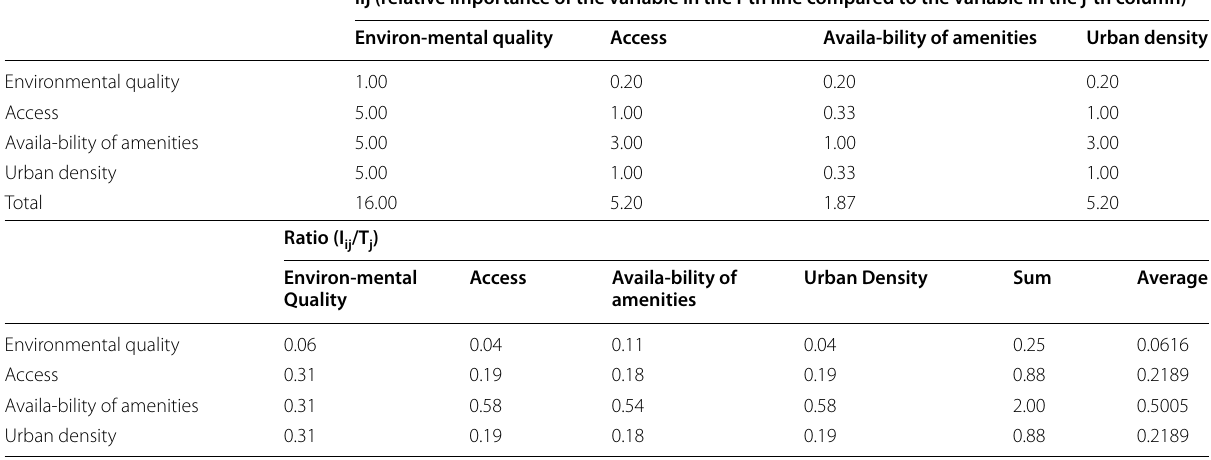
Table 2 Relative importance of the dimensional indicators of availability of Amenities (I_LU), of Accessibility (I_ACC), Urban density (I_UD), and Environmental Quality (I_EQ) Iij (relative importance of the variable in the i-th line compared to the variable in the j-th